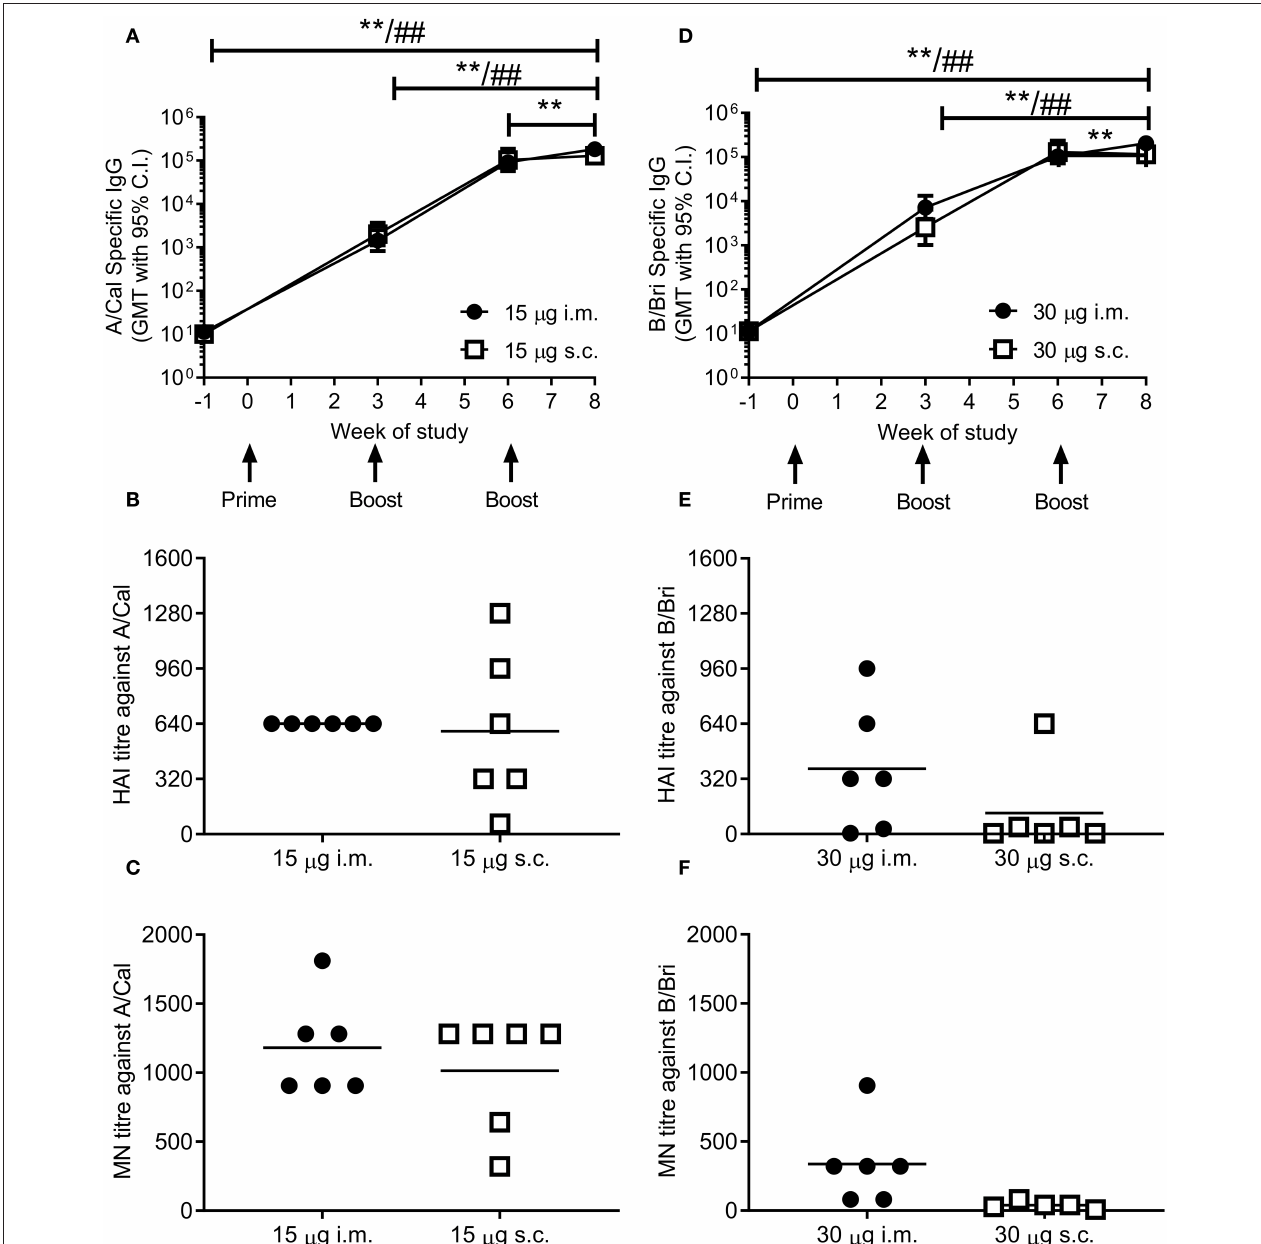
FIGURE 2 | Ciliate produced rHA induces an antibody response in mice. BALB/c mice were immunized three times at 3 weekly intervals with either 15 µ g A/Cal (A–C) or 30 µ g B/Bri (D–F) by the intramuscular (i.m.) or subcutaneous (s.c.) routes. A/Cal-specific and B/Bri-specific IgG were evaluated in sera collected before immunization (week -1) and at weeks 3, 6 and 8, by ELISA. Values are reported as geometric mean titers (GMT) ± 95% CI of 6 mice per group (A,D) . Sera for haemagglutination inhibition (HAI: B,E ) and microneutralization (MN: C,F ) analysis were collected at week 8. Symbols represents individual mice and bars represents the mean of n = 6 animals (B,C,E,F) . ** p < 0.01 between i.m. at week 8 and other time points, ## p < 0.01 between s.c. at week 8 and other time points by ANOVA and Tukey post test for multiple